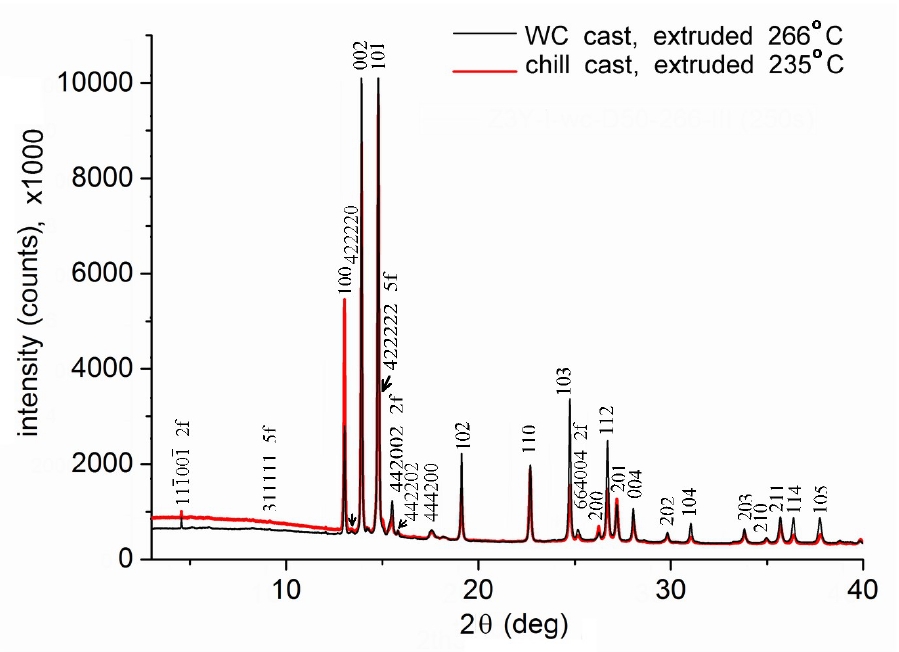
Figure 9. Synchrotron X-ray diffraction patterns of the extruded rods after extrusion of chill cast and water-cooled mold castings. Three digit indices are for α -Mg planes and six digits for the icosahedral phase (twofold and fivefold symmetry planes are marked 2f and 5f, respectively).